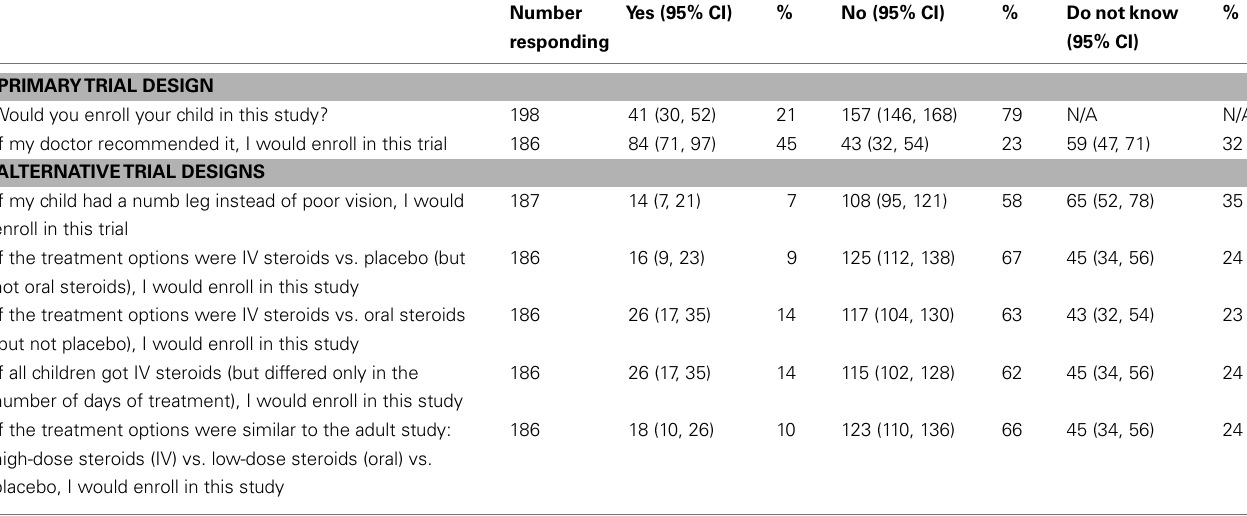
Table 2 | Parental willingness to